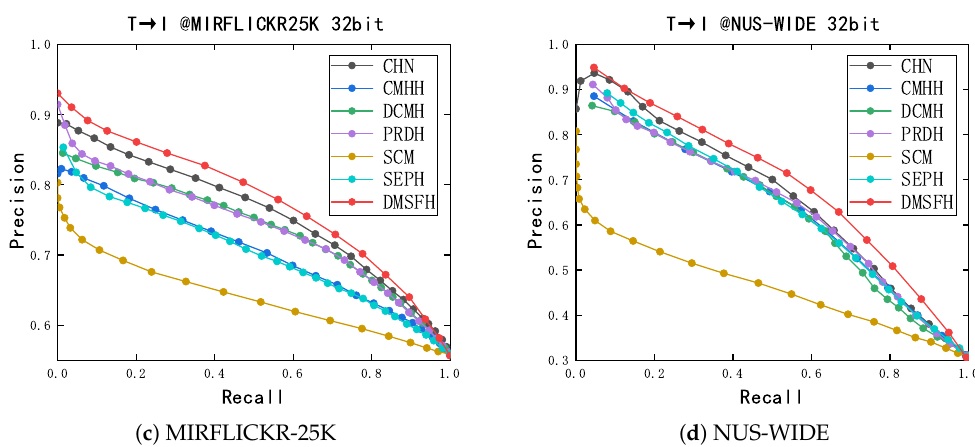
Figure 4. Precision-Recall curves on MIRFLICKR-25K and NUS-WIDE dataset. I → T query: ( a , b ); T → I query: ( c , d ). The code length was 32 bits.